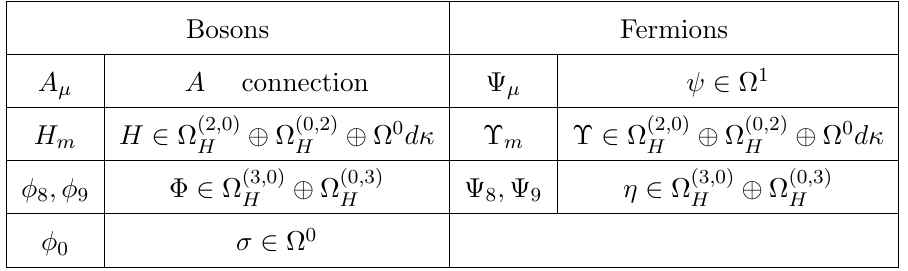
Table 1 . Mappings of the bosonic and fermionic (cid:12)elds of our theory to di(cid:11)erential forms. ( X; X 0 )- pairs of bosons and fermions appearing in the transformations (3.49){(3.51) are written on the same line. Note that we have suppressed the Lie algebra